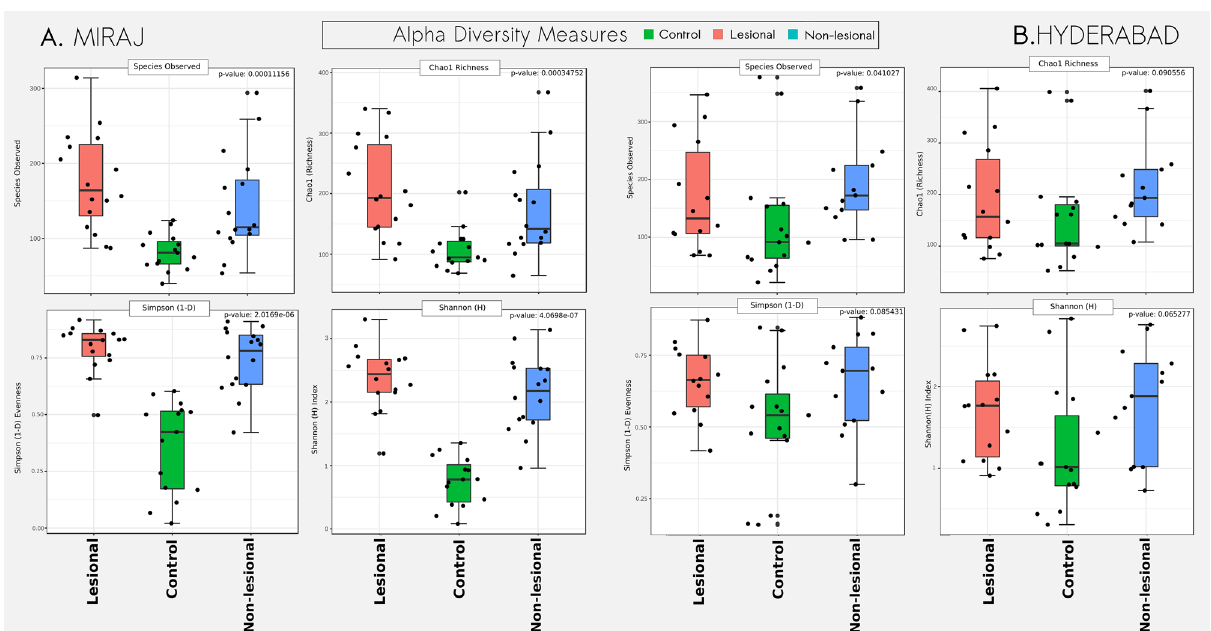
Figure 4. Alpha-diversity trends in microbiota samples obtained from healthy controls and lesional and non- lesional skin sites of leprosy patients. Box plots illustrating the comparison of diversity indices (S-Obs, Chao-1, Simpson1-D and Shannon) between skin microbiota samples obtained from HC and LS and NLS sites of LP from Miraj (A) and Hyderabad (B)